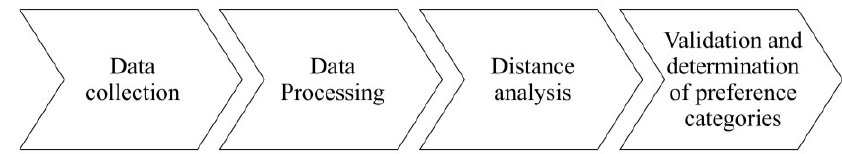
Figure 3. Process of proximity